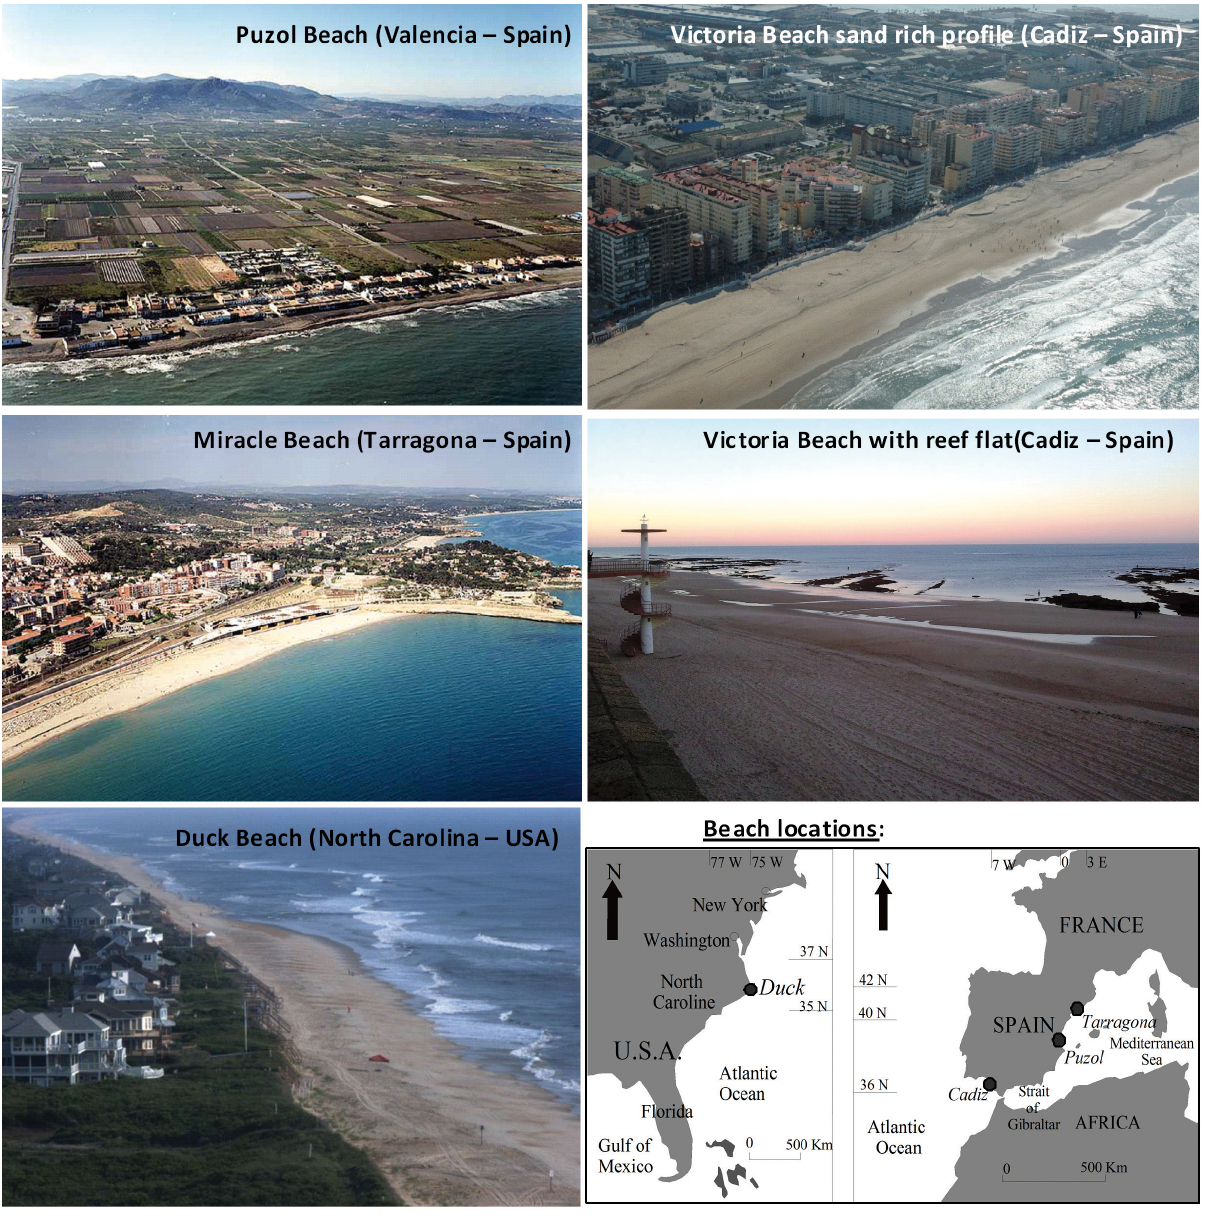
Fig . 1. – Location and photographs of the beaches studied. Table 1. – Parameters related to the studied beaches. D , sand mean grain size; Average slope, percentage of slope related to the mean profile; 50 TR, tidal range; H , significant wave height; h , closure depth in relation to the lowest low water level. s * Beach name and